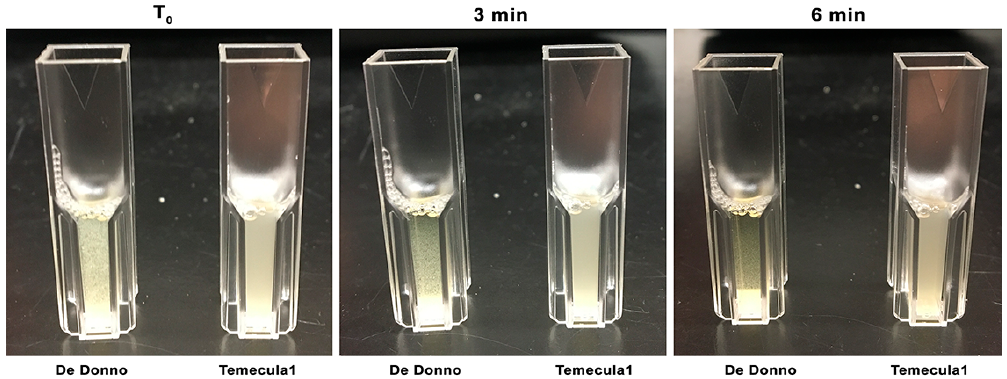
Figure 3. Comparison of precipitation behavior between X. fastidiosa strains Temecula1 and De Donno used in this study. Bacterial cells were suspended in a 1 mL-cuvette in the PD3 medium and allowed settling for 6 min. Strain De Donno showed reduced turbidity, index of a faster settling, already visible after 3 min.